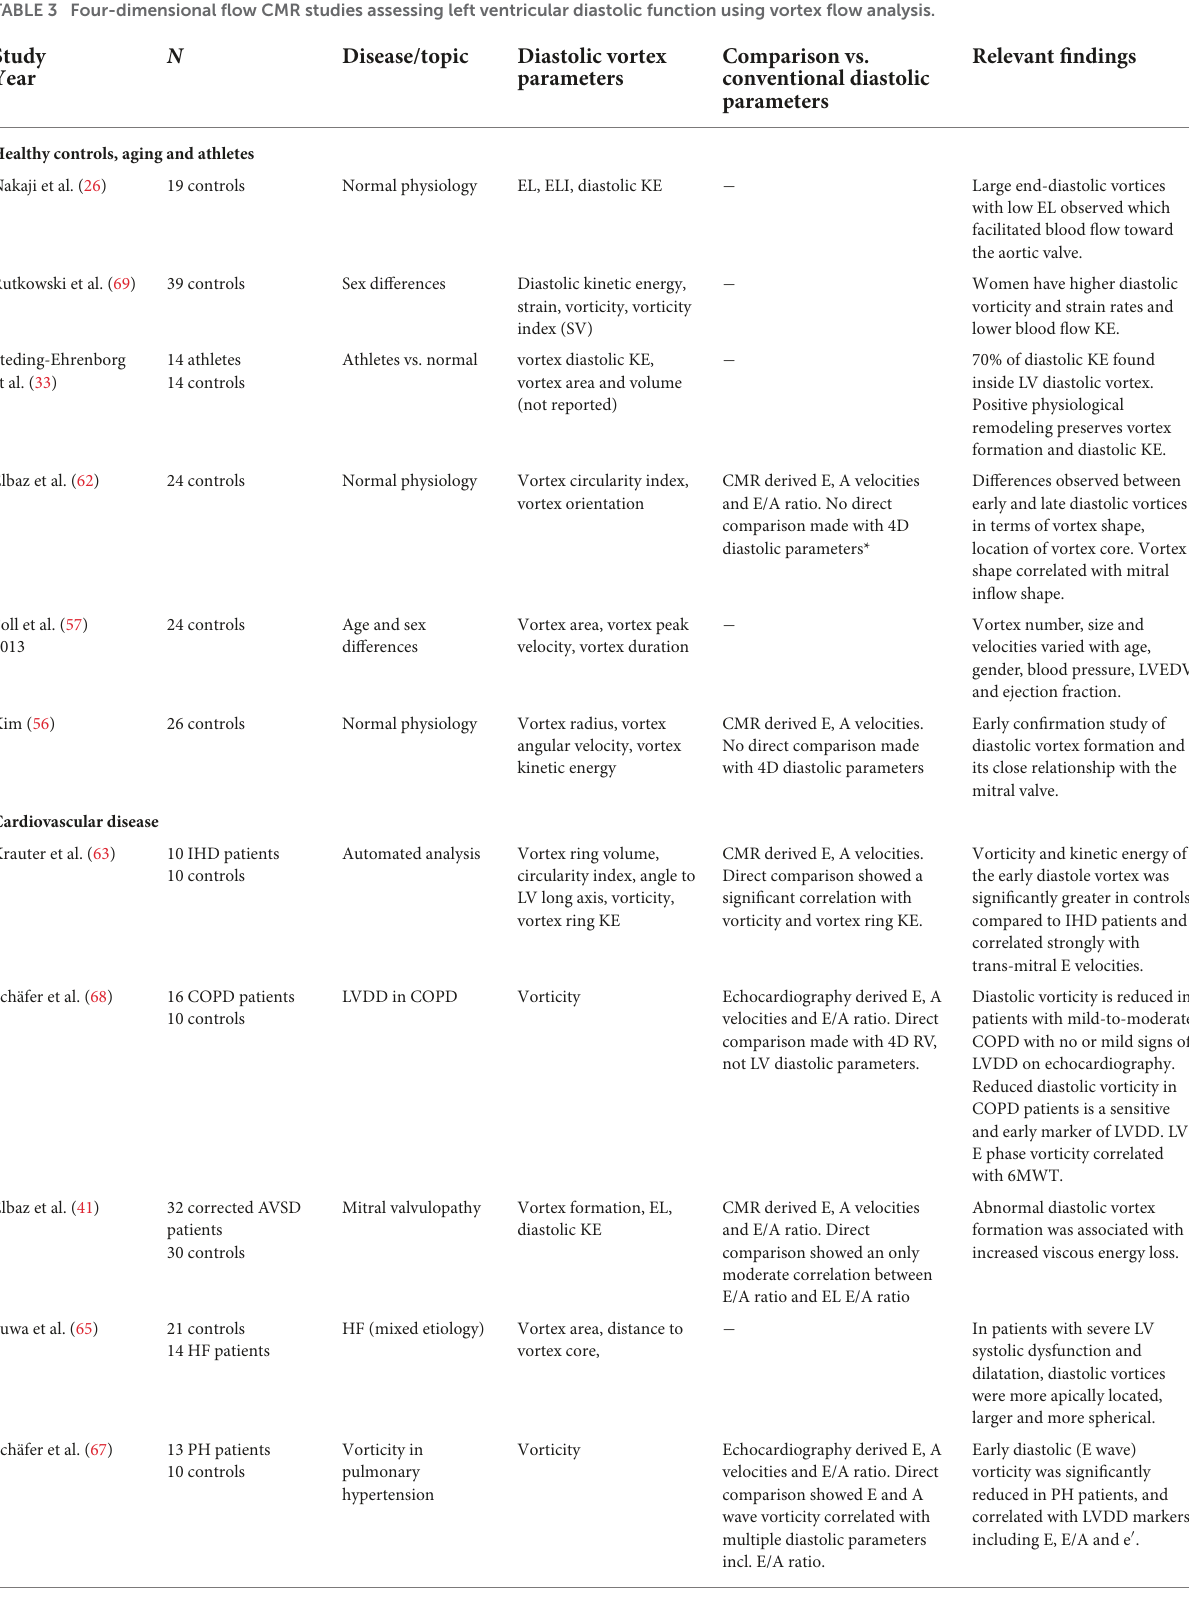
TABLE 3 Four-dimensional flow CMR studies assessing left ventricular diastolic function using vortex flow